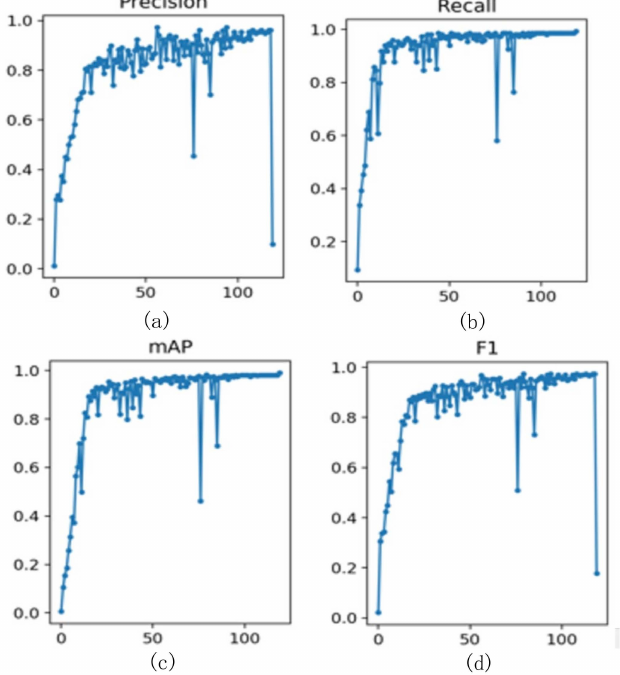
Figure 15. Results after 100 iterations. ( a ) Accuracy results. ( b ) Recall results. ( c ) mAP results. ( d ) F1